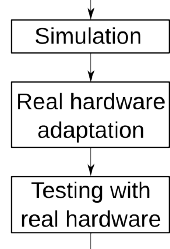
Figure 1: Conventional algorithm development process.